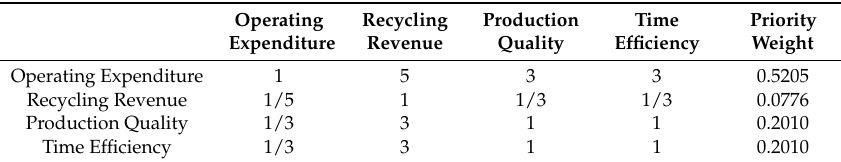
Table 5. Pairwise Comparison of Sub Criteria w.r.t. Business Sustainability.